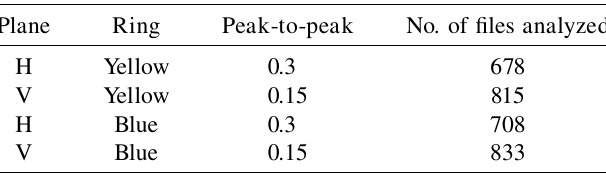
TABLE I. Thresholds for peak-to-peak values